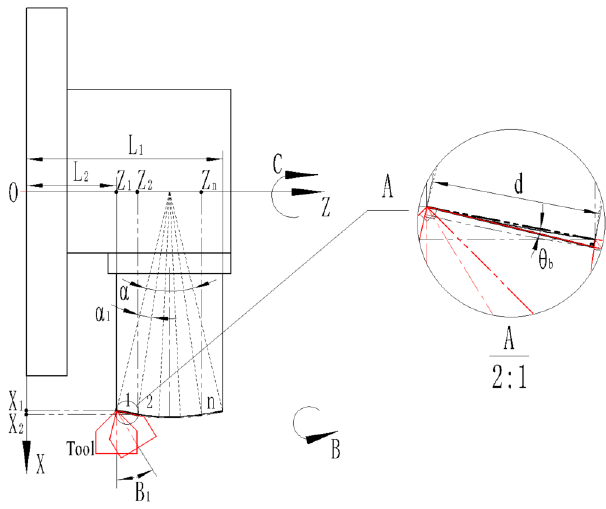
Figure 6. Processing schematic with equal-along-arc layout.